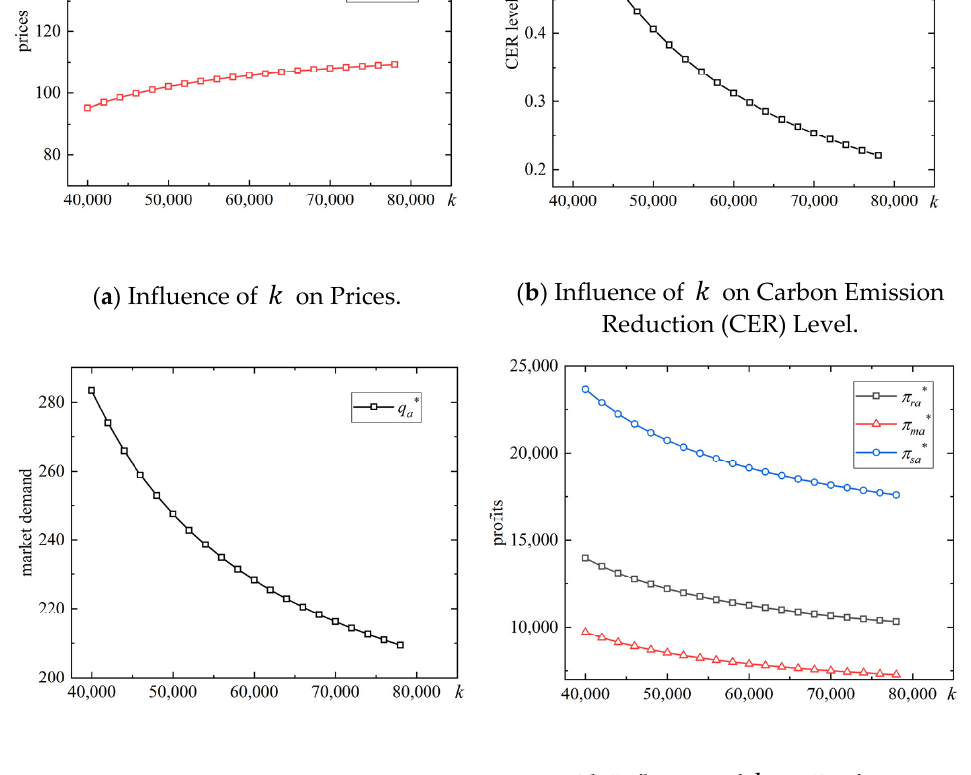
Figure 2. The Influence of Carbon Emission Reduction Cost 𝑘 on Supply Chain Decision.